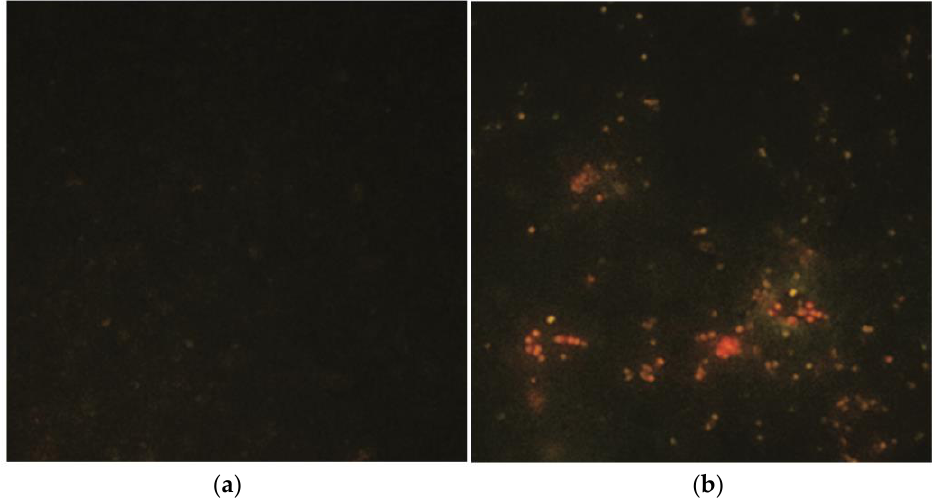
Figure 5. Fluorescence microscopy for an MRSA strain (ATCC 700698) stained with MitoTracker Red showed more intense intracellular production of ROS ( a ) after the mitocurcumin treatment compared ( b ) with no treatment.